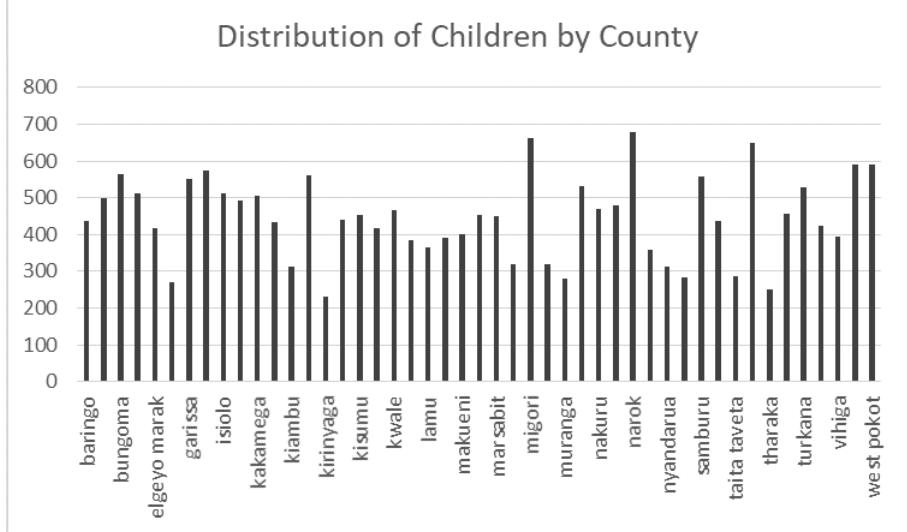
Figure 1. Distribution of children by county.